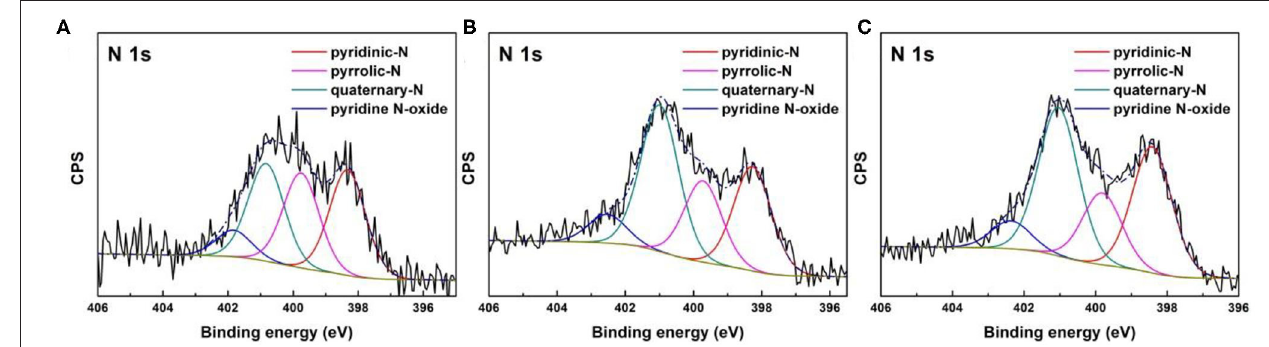
axis. The low frequency sloping line corresponds to the Warburg impedance ( Z w ) that pertains the ion diffusion in the electrode. Comparison of R ct values for three MC-7 materials reveals the lowest R ct of MC-7-SD, corresponding to improved